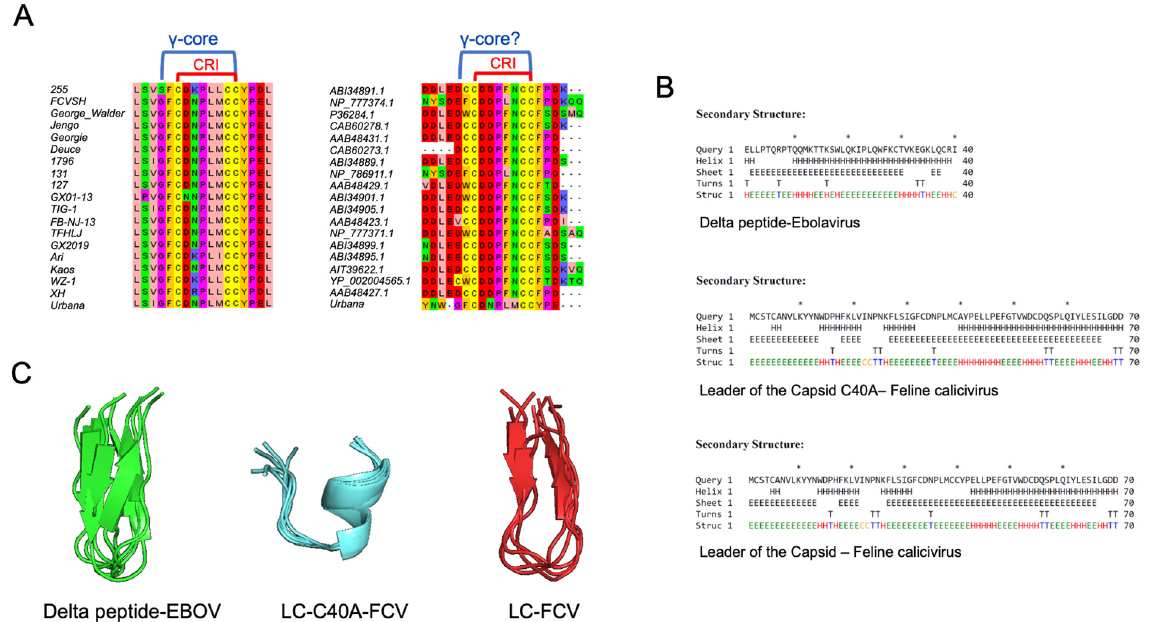
Figure 2. LC from FCV has defensin-conserved multidimensional γ -core motif. ( A ) Representative image of the alignment of the CRI motif sequences of LC protein from diverse FCV strains and isolates (left) or from other vesiviruses (right). ( B ) Secondary structure prediction of the delta peptide from EBOV and the mutant LC-C40A and WT-LC proteins from FCV (upper, middle, and lower panels, respectively). “H” indicates alpha helixes, “E” beta sheets, “C” coils, and “T” turns. ( C ) Tertiary structure prediction of the cysteine-containing conserved region from delta peptide from EBOV (green), the CRI from WT-LC (red), and mutant-LC-C40A (blue) proteins from FCV by the use of PEPFOLD 3.5 software. The five proposed models were modelled and aligned with Pymol (DeLano Scientific LLC, CA, USA).